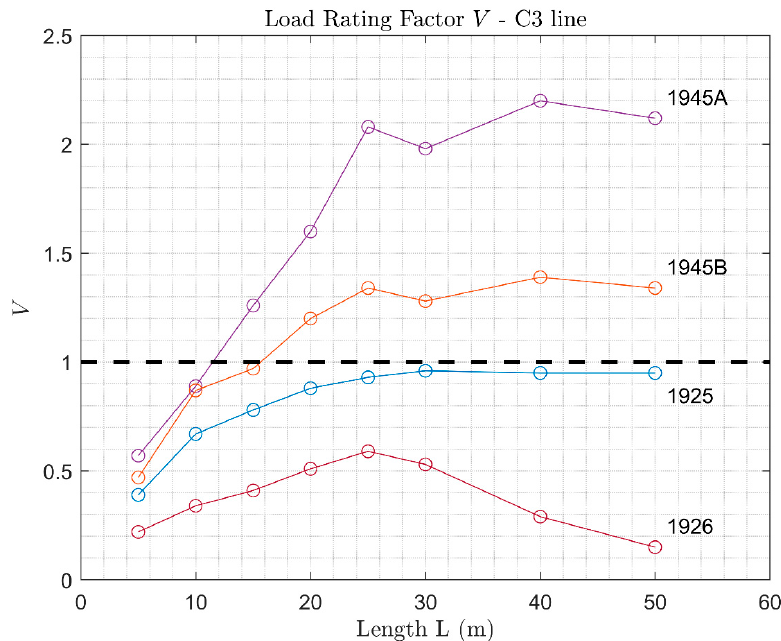
Figure 15. Load Rating Factor of arches verified with C3 loads, with dynamic amplification.